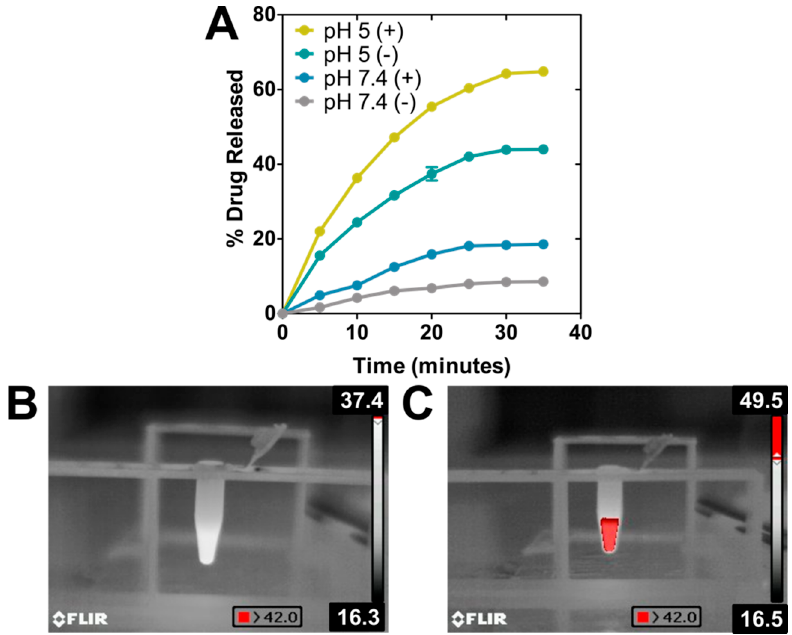
Figure 3. BMNPs as drug nanocarriers. ( A ) DOXO release temporal curves under the presence (+) or absence ( − ) of NIR-laser power of 2 W cm − 2 at physiological and acidic pH ([Fe] = 19 mM). Thermographic photographs of samples without ( B ) and with ( C ) BMNPs irradiated with the laser. Table 1. Summary of values of drug encapsulation and drug release efficiency under different conditions. System Drug Encapsulation Efficiency (%) a Values calculated with the equation described in [32] after 40 min of treatment. b PTH = photothermal treatment with an irradiation of 2 W cm − 2 .